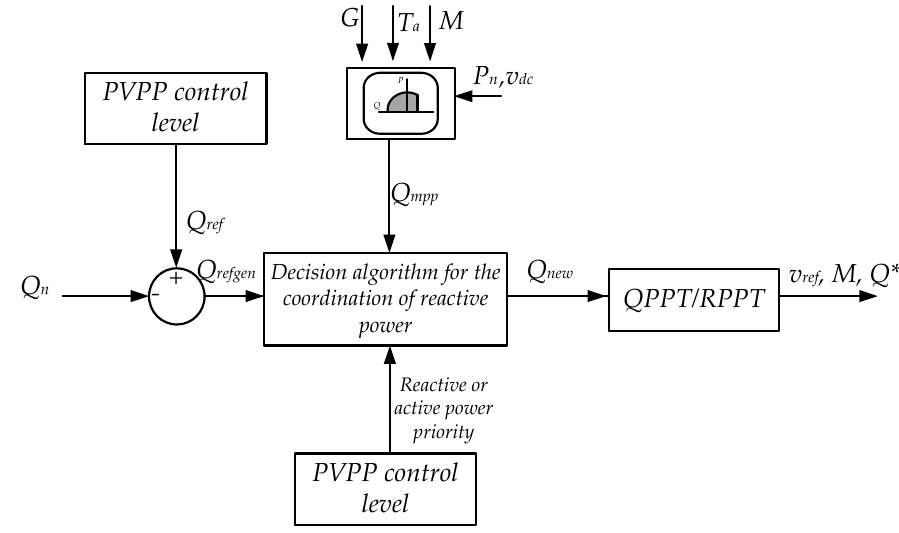
Figure 15. Control scheme for control of reactive power in PV